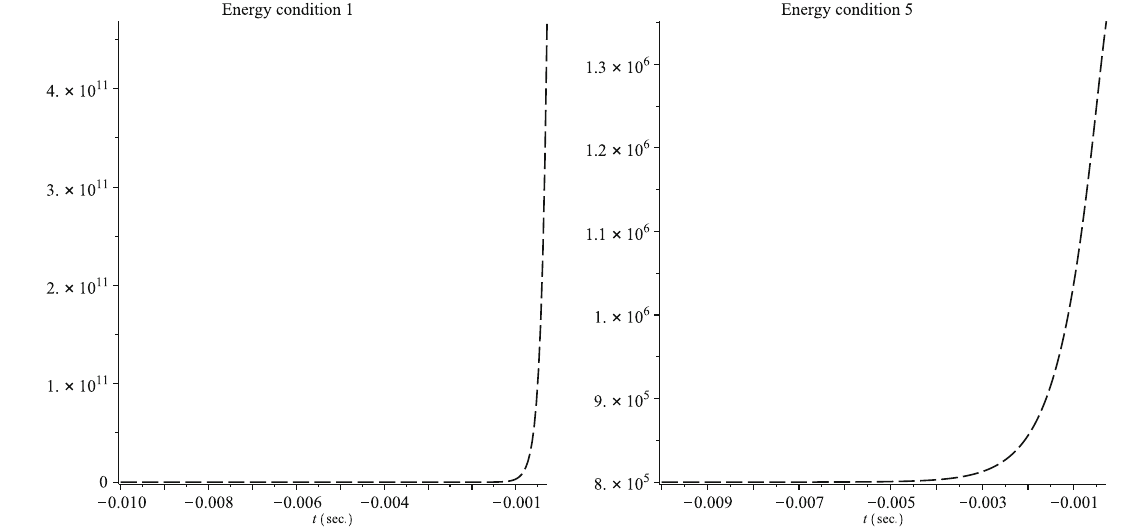
Fig. 5 (Left) the quantities in left hand side of energy condition (i) are plotted in left panel. The expression remains positive throughout the collapse process. (Right) the quantities in energy condition (v) are plotted in the right panel. This expression also remains positive during